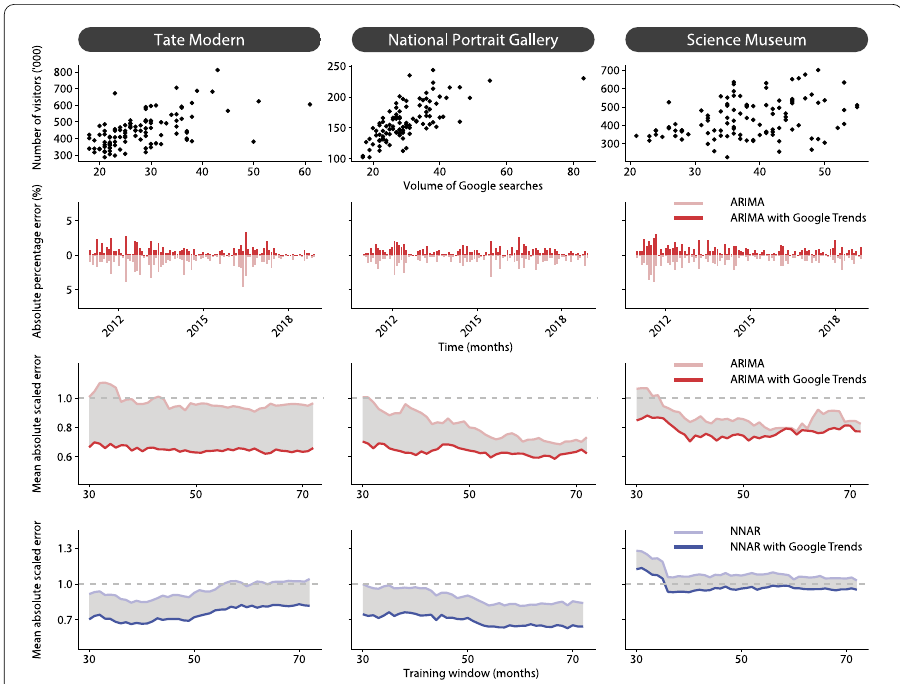
Figure 1 Rapid estimates of museum and gallery visitor numbers using Google search data. Toprow : We investigate whether we can generate rapid estimates of visitor numbers for a range of museums and galleries in the UK using data on how frequently a museum has been searched for on Google . Here, we illustrate our findings using three example museums: the TateModern , the NationalPortraitGallery and the ScienceMuseum group. We compare visitor numbers provided by the DepartmentforDigital,Culture,Media,andSport , and data on the volume of searches for each museum on Google between January 2010 and December 2018. We find that more Google searches tend to correspond to more visits to the museum ( TateModern : Kendall (cid:2) s τ =